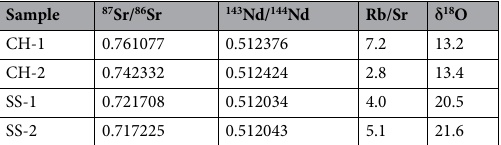
Table 3. Sr and Nd isotopic data and oxygen isotope